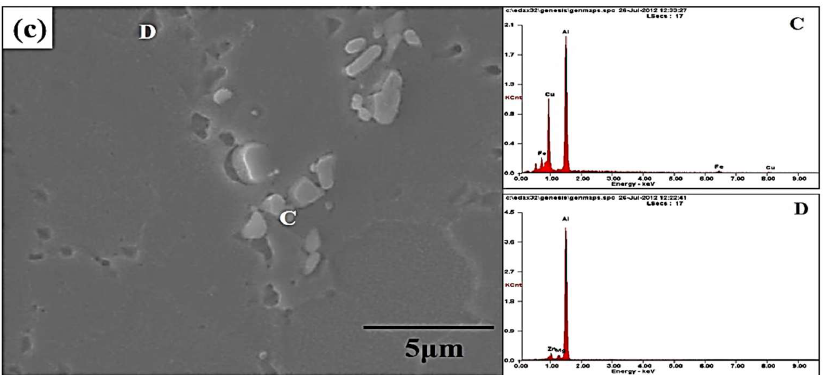
Figure 8. Microstructural morphology and analysis of the intermetallic particles and micro-voids: ( a ) microstructures; and ( b , c ) micro-voids and intermetallic particles at different locations. Table 2. Engergy dispersive spectrometer (EDS) for examined specimens, which is shown in Figure 8b,c.